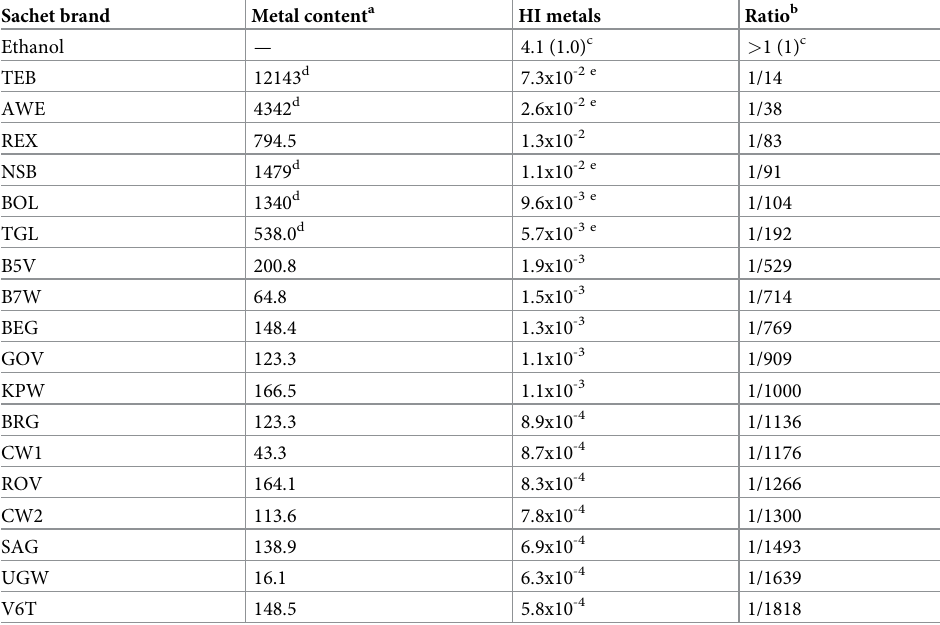
Table 4. The levels of metals ( μ g/L) in each brand of alcohol and their associated health indices (HI). HI is listed from the most significant (top) to the least